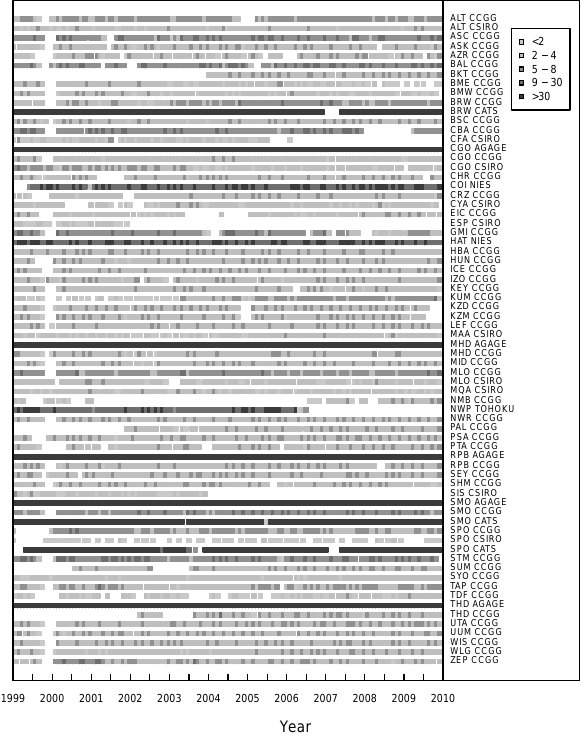
Fig. 2. N 2 O observation availability at individual sites for the in- version period 1999 to 2009. The legend indicates the number of observations per